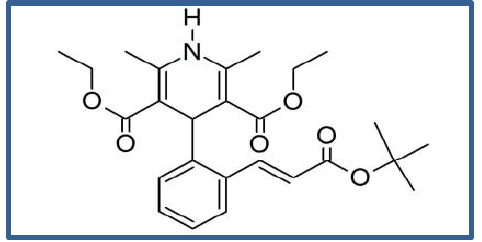
Figure 1. The chemical structure of LCDP (8) LCDP poorly absorbed from the gastrointestinal tract after oral doses and undergoes extensive first-pass metabolism the 10%. The rate limiting step for drug absorption in this class is dissolution (9)